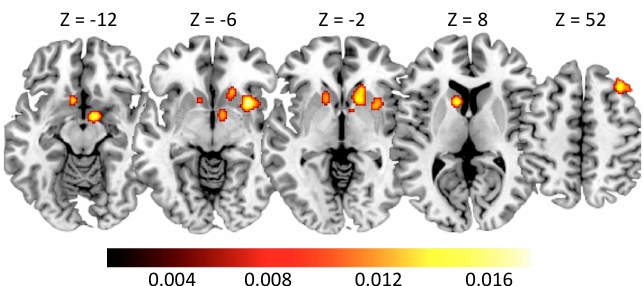
Figure 2. Clusters of activation in Gambling Disorder subjects. Montreal Neurological Institute (MNI) coordinates are provided. The color bar indicates activation likelihood estimation (ALE) values.